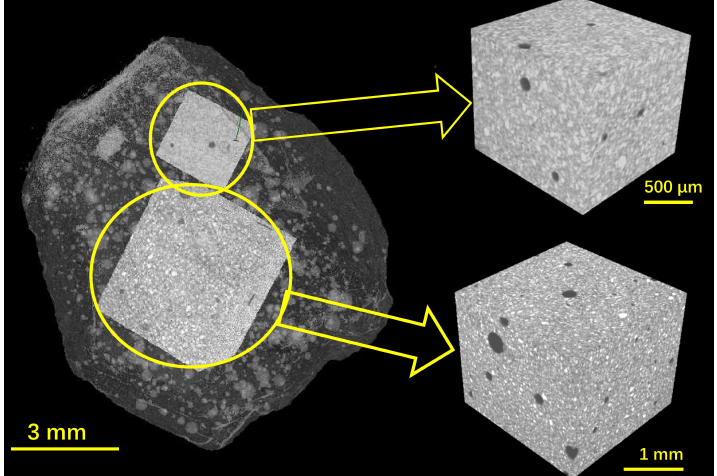
Figure 3. An example of VOI selections from a pre-MIP paste